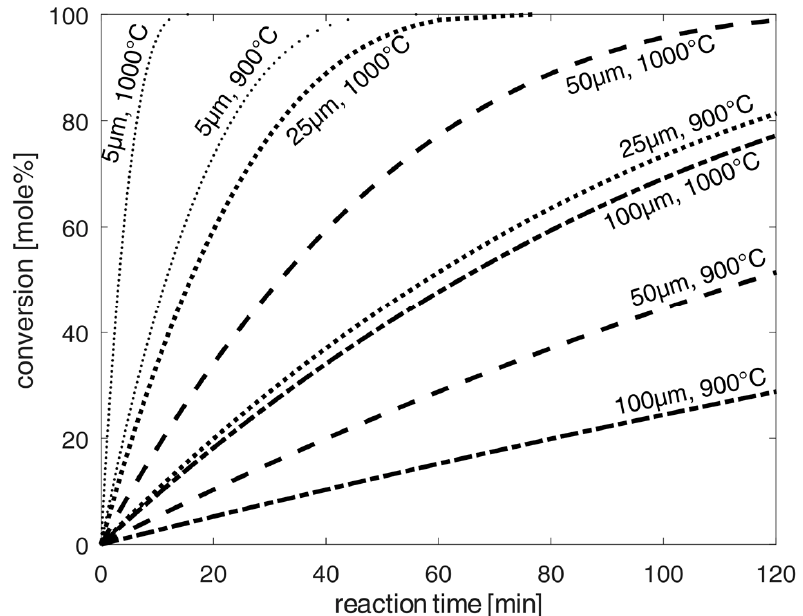
Figure 4. Estimation of the progress of chlorination of spherical oxidized NdFeB-magnet material particles at 1173–1273 K according to the shrinking-core model [20] and the kinetic data from [25–28,34], and diffusion according to [22] for diffusion in air. Uncertainties of calculated values are mainly caused by uncertainties of kinetic constants and activation energies given in the literature. The variation in these parameters results in the average uncertainty of 25%, slightly depending on the reaction temperature.